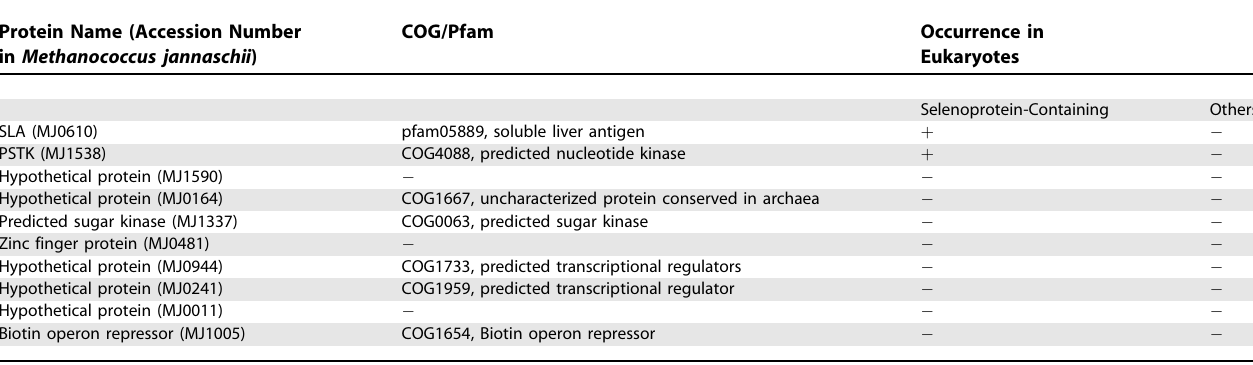
Table 2. Phylogenetic Profiles of Archaeal Proteins That Are Present Exclusively in Selenoprotein-Containing Archaea Protein Name (Accession Number in Methanococcus jannaschii )